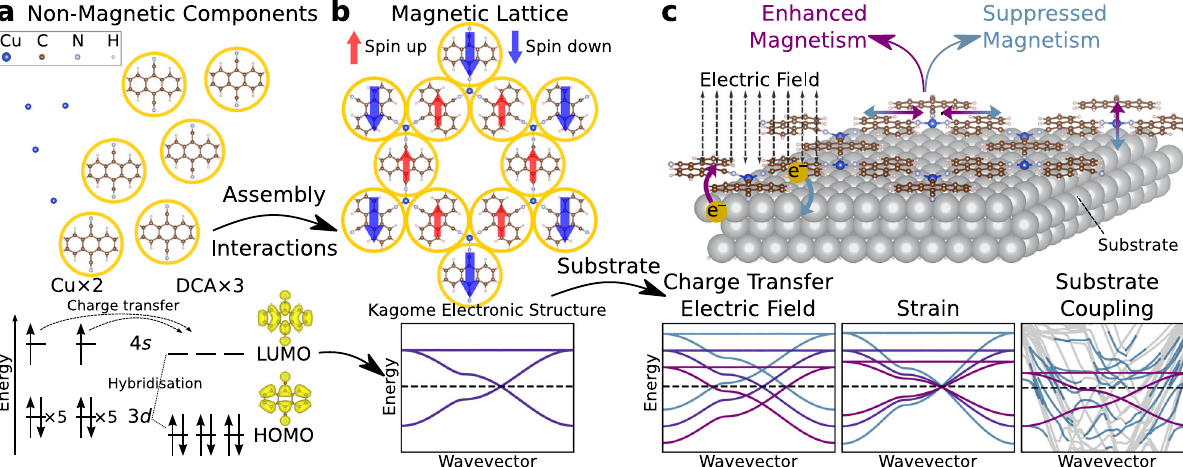
Fig. 1 Schematic depiction of interaction-induced magnetism in a 2D MOF and how substrates in fl uence it. a Ball-and-stick models of DCA and Cu, the components of the MOF, and their isolated electronic structures. The copper(I) ions and DCA molecules in the MOF are not intrinsically magnetic. b Ball-and-stick model of DCA-Cu kagome MOF, where intra-MOF electron-electron Coulomb interactions induce magnetic moments. The MOF has a kagome electronic band structure derived from the DCA LUMO (non-spin-polarised schematic shown). c Ball-and-stick model of DCA-Cu MOF on a substrate and schematic band structures. The magnetism in the MOF is in fl uenced by coupling to the substrate, charge transfer either out of or into the MOF (such as by an applied electric fi eld), and strain, which alters the bandwidth. The strength of the magnetic moments can be enhanced by using a weakly interacting substrate, favourable electron fi lling of the MOF by choice of substrate work function or application of electric fi elds, and by applying tensile strain to the MOF such as by lattice mismatch. (HOMO: highest occupied molecular orbital. LUMO: lowest unoccupied molecular